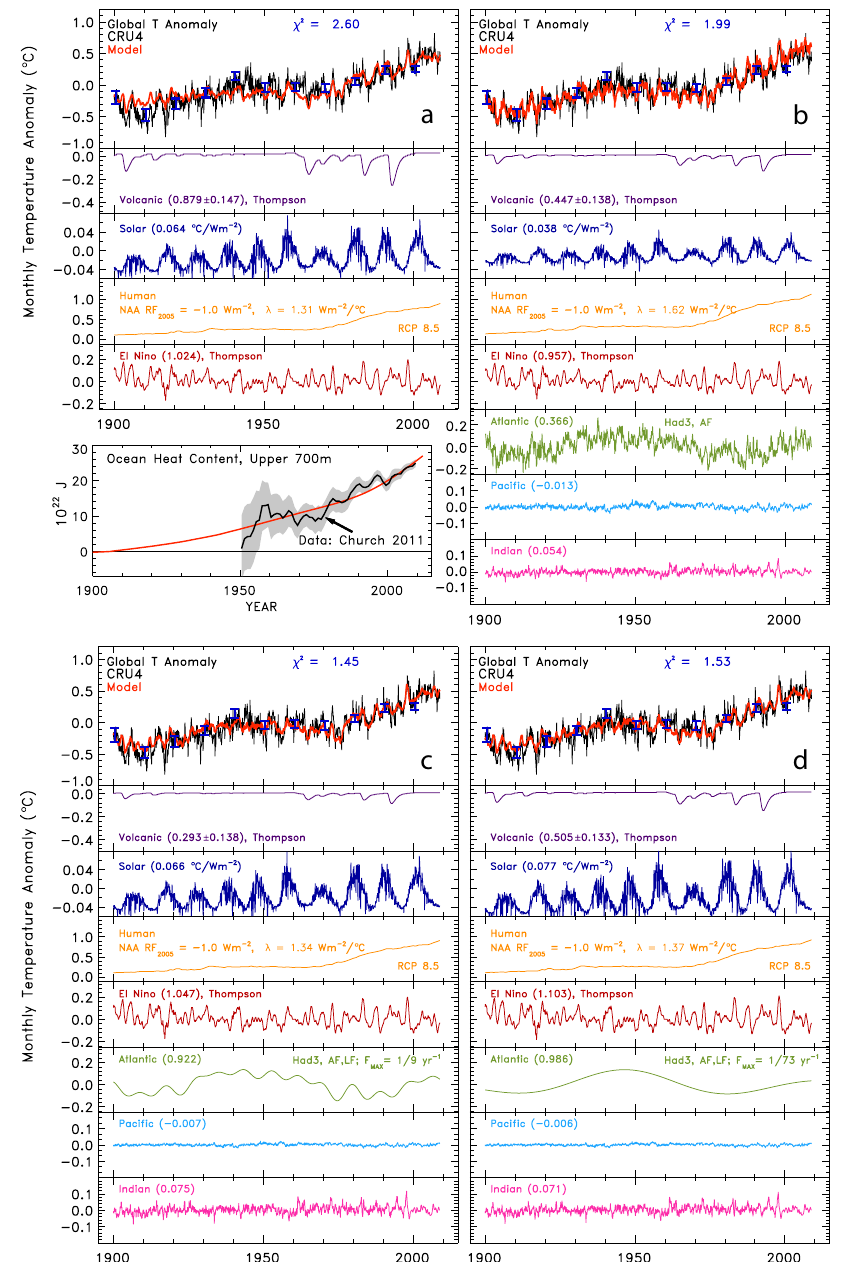
Fig. 7. (a) Same as Fig. 6a, except indices for ENSO and SOD have been replaced by values for the response of global temperature to ENSO and volcanic eruptions found by the thermodynamic model of Thompson et al. (2009), with no temporal delay. (b) Same as Fig. 6d, except the response of global temperature to ENSO and volcanic eruptions found by Thompson et al.(2009) are used. (c) Same as (b) , except the AMV index has been filtered to remove all components with frequencies higher than 1/9yr − 1 . (d) Same as (b) , except the AMV index has been filtered to remove all components with frequencies higher than 1/73yr − 1